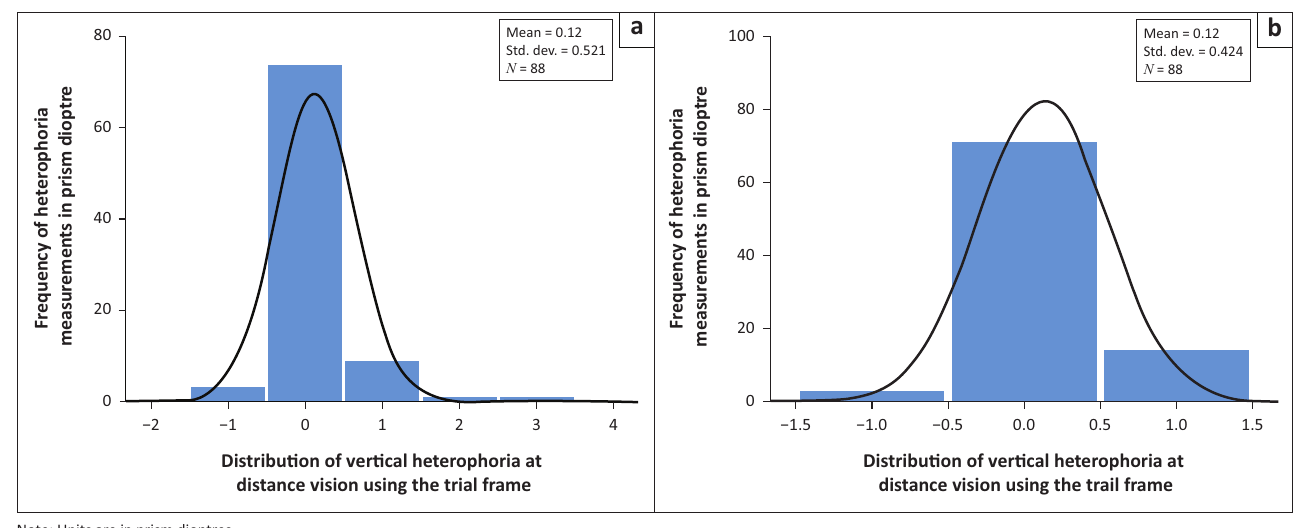
Note: Units are in prism dioptres. Std. Dev., standard deviation. FIGURE 3: Histograms for near horizontal heterophoria using the phoropter (a) and trial frame (b).